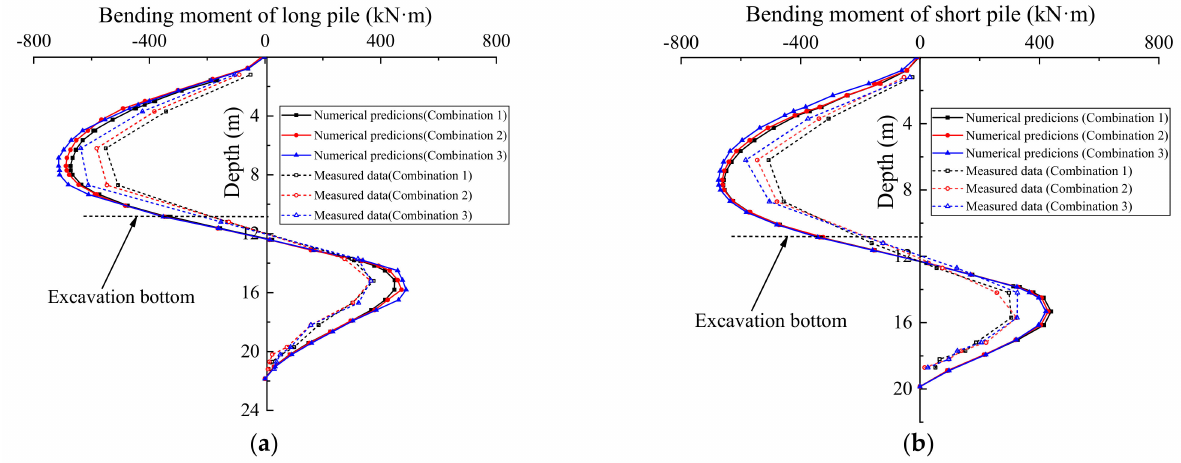
Figure 13. Comparison between simulation results and measured results of bending moment: ( a ) long pile; ( b ) short